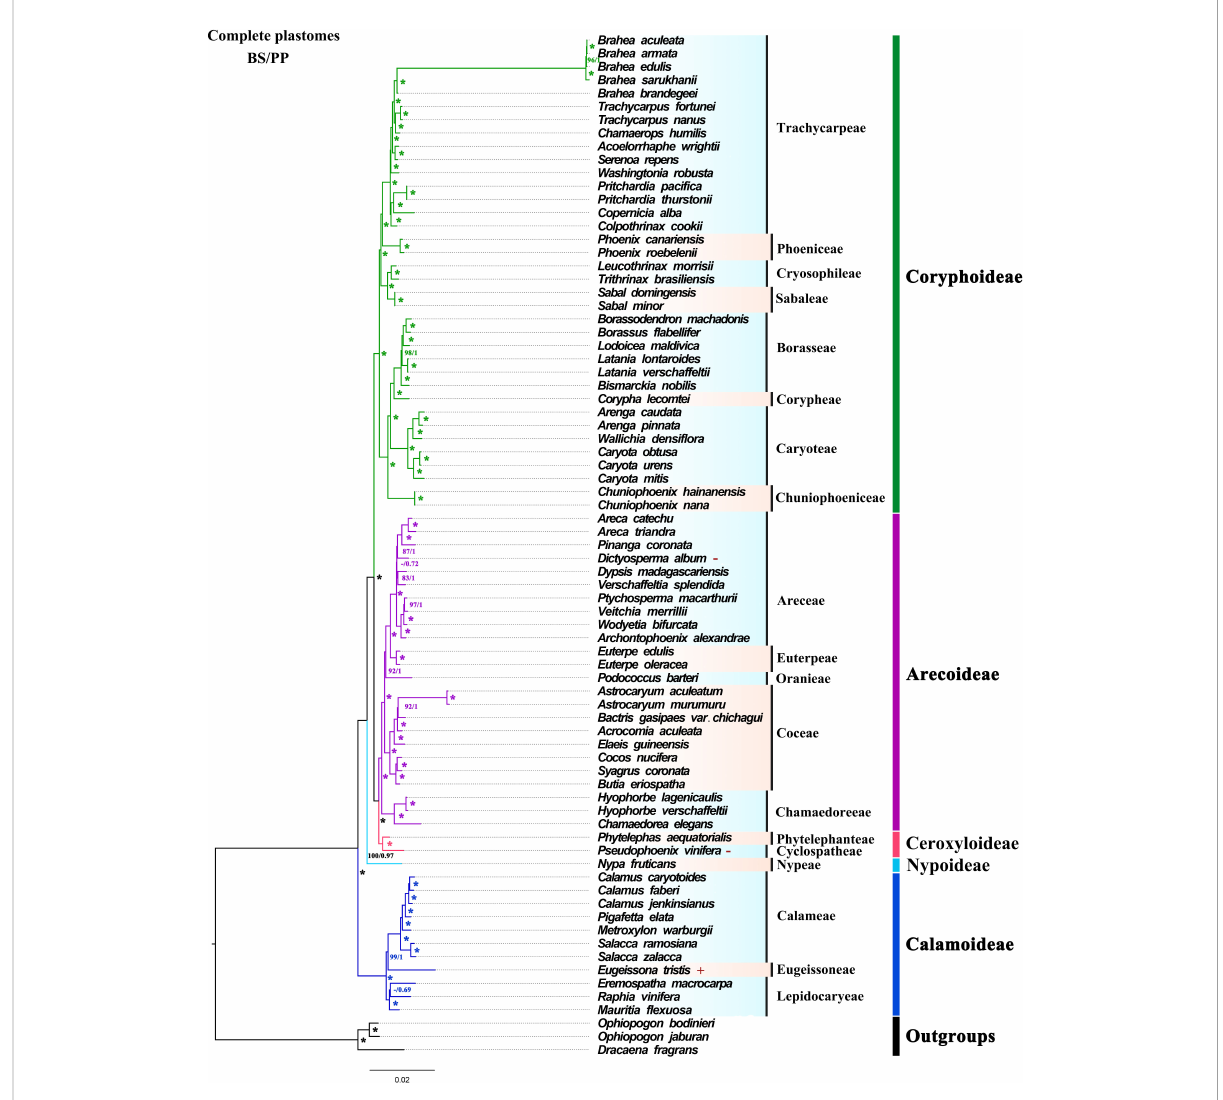
FIGURE 5 ML and BI trees were constructed based on the whole chloroplast genome dataset. “ * ” indicate support values of 100%/1.0, numbers near the nodes indicate 60% and 0.6 or more support obtained from the analysis, and “ - ” is used when both support values are less than 60% or 0.6. Different colors represent different clades of subfamilies. The “ + ” presented to the right of the species indicates that the species expands at the IR/SC boundary, and “ - ” indicates that the species contracts at the IR/SC